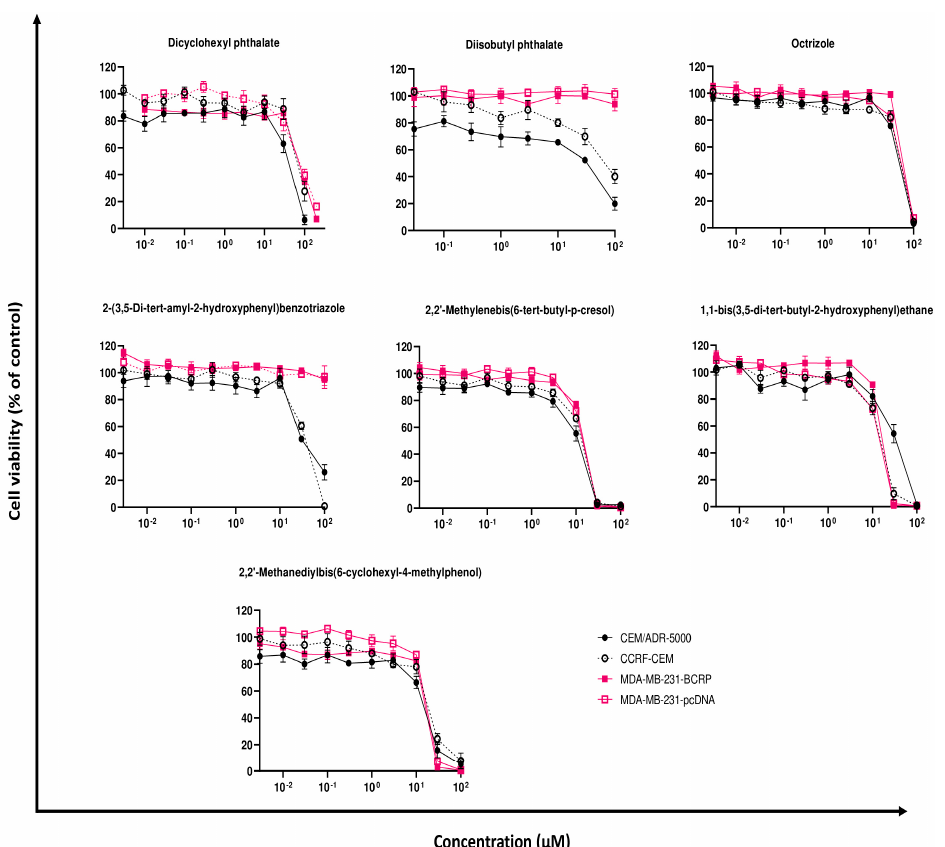
Figure 4. Resazurin assay of drug-sensitive CCRF-CEM and MDA-MD-231-pcDNA and multidrug- resistant CEM/ADR5000 and MDA-MD-231-BCRP treated with different concentrations of the 7 selective compounds. All experiments were performed in three replicate measurements of mean ± SD.